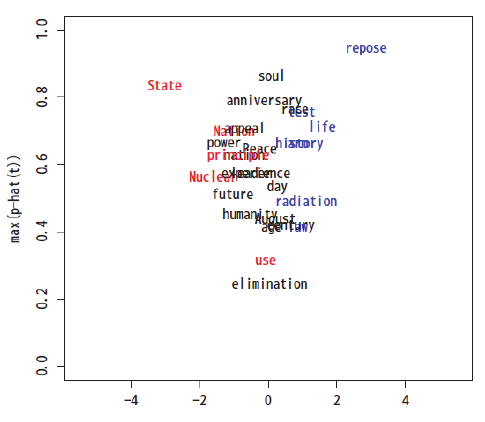
Fig. 21. Scatter plot of keyword's appearance by cluster in 1987